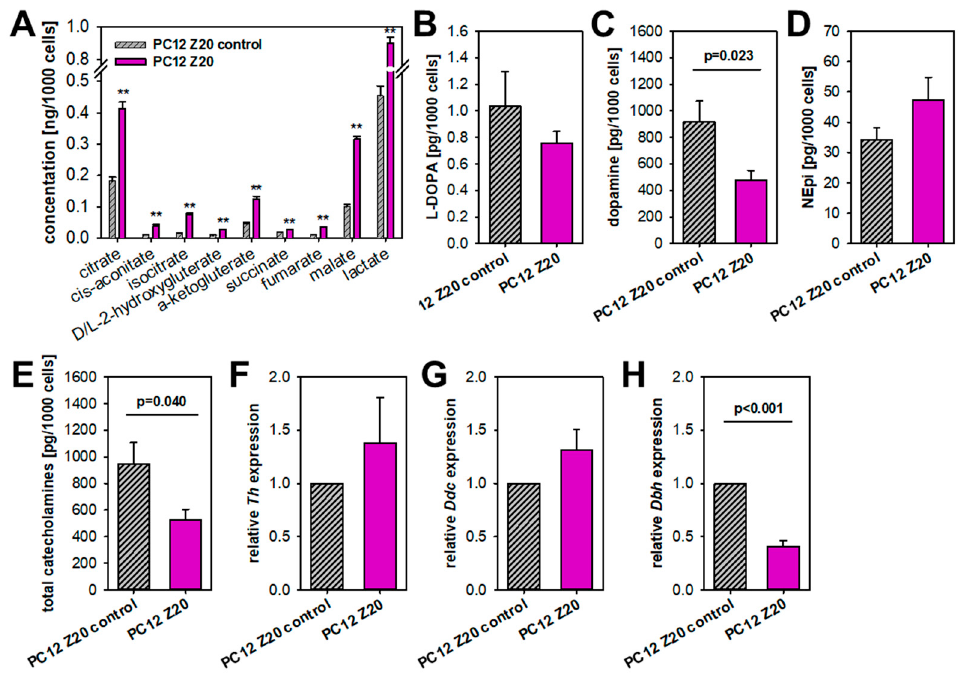
Figure 4. Metabolic differences between PC12 Z20 and PC12 Z20 control cells under normoxic con- ditions. ( A ) PC12 Z20 cells showed an accumulation of TCA cycle metabolites compared with the control cells. Four independent experiments ( n = 16). Mean ± SEM; Anova and Bonferroni post hoc test comparison vs. PC12 Z20 control ** p < 0.001. ( B ) L-DOPA, ( C ) dopamine, ( D ) norepinephrine (NEpi) and ( E ) total catecholamine content of PC12 Z20 and PC12 Z20 control cells. Four independ- ent experiments ( n = 8). Relative expression of ( F ) tyrosine hydroxylase ( Th ), ( G ) DOPA decarbox- ylase ( Ddc ), and ( H ) dopamine beta-hydroxylase ( Dbh ) in PC12 Z20 and PC12 Z20 control cells. Mean ± SEM; unpaired t -test comparison vs. PC12 Z20 control.